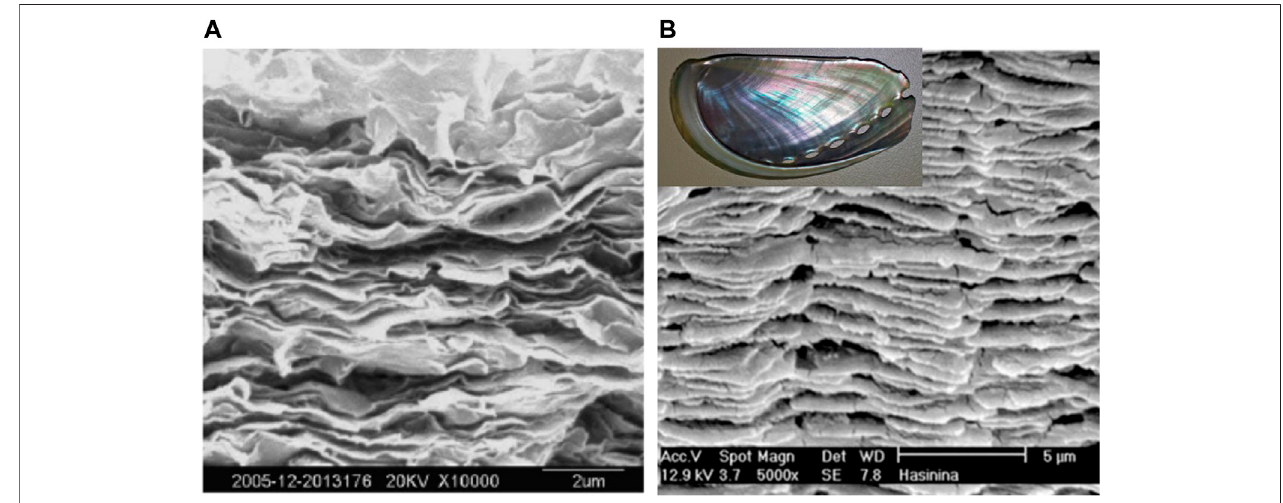
FIGURE 10 | (A) A cross-section of the MMT/polyacrylamide multilayer structure deposited by EPD (Reprinted from Polyacrylamide-clay nacre-like nanocomposites prepared by electrophoretic deposition. Compos. Sci. Technol. 67, 2770 – 2774 (2007) with permission from Elsevier), (B) SEM micrograph of the nacreous layer of the cross-section in Haliotis asinina illustrating the columnar superimposition of nacre tablets that is characteristic of gastropod nacre (Copyright © 2010, Marie et al.; licensee BioMed Central Ltd.). Inset: “ Haliotis asinina (donkey ’ s ear abalone) 3 ” by James St. John is licensed under CC BY 2.0. Available on: https://commons.wikimedia.org/wiki/File:Haliotis_asinina_(donkey%27s_ear_abalone)_3_(24222578015).jpg.